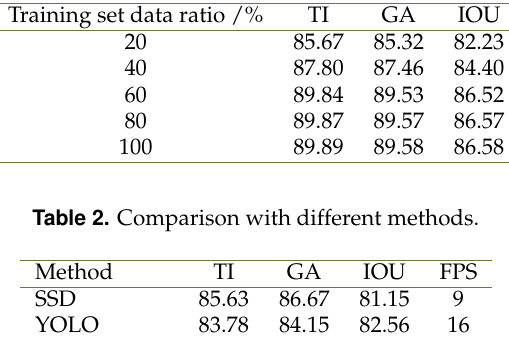
Fig. 4. Training loss value.